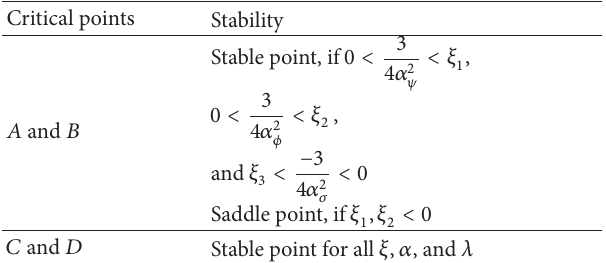
Table 2: Eigenvalues of the perturbation matrix for each critical point.